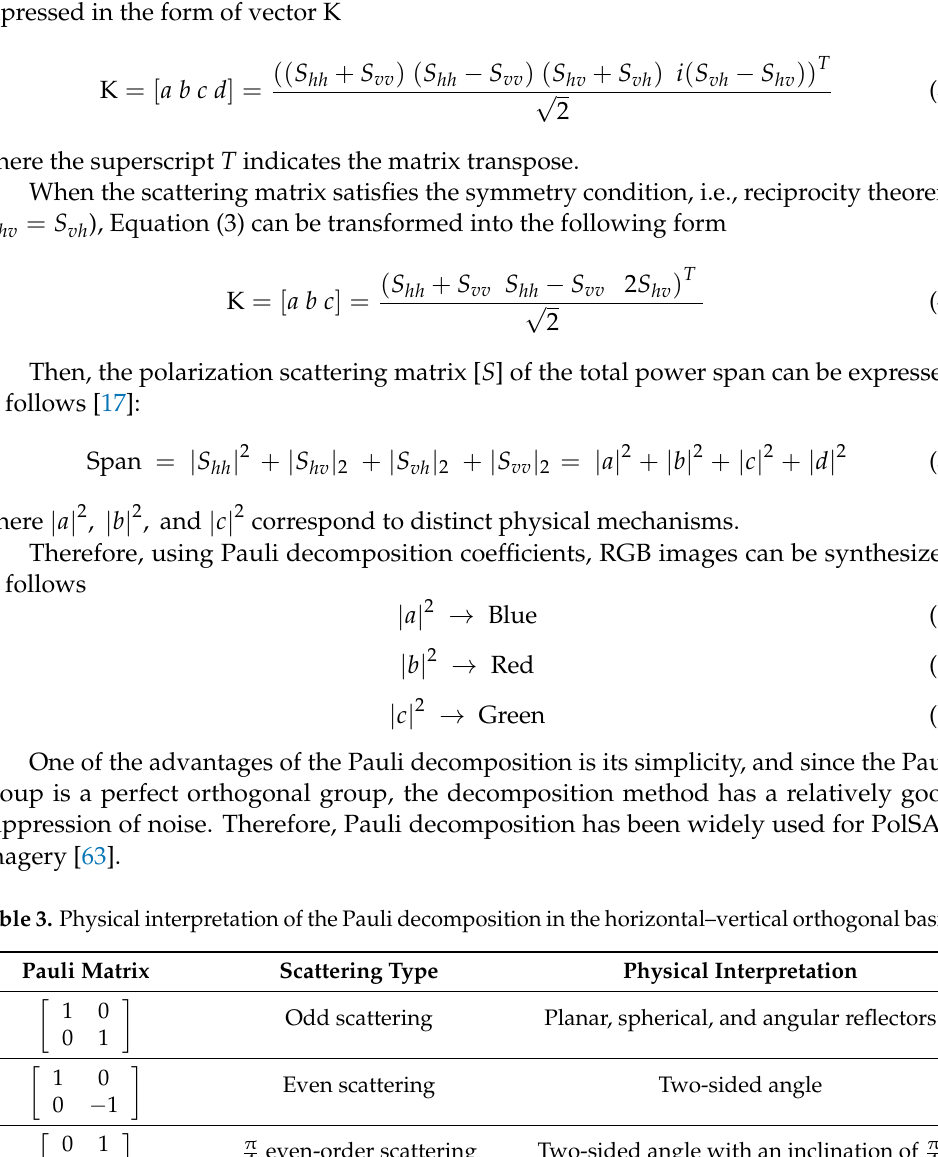
No corresponding scattering mechanism